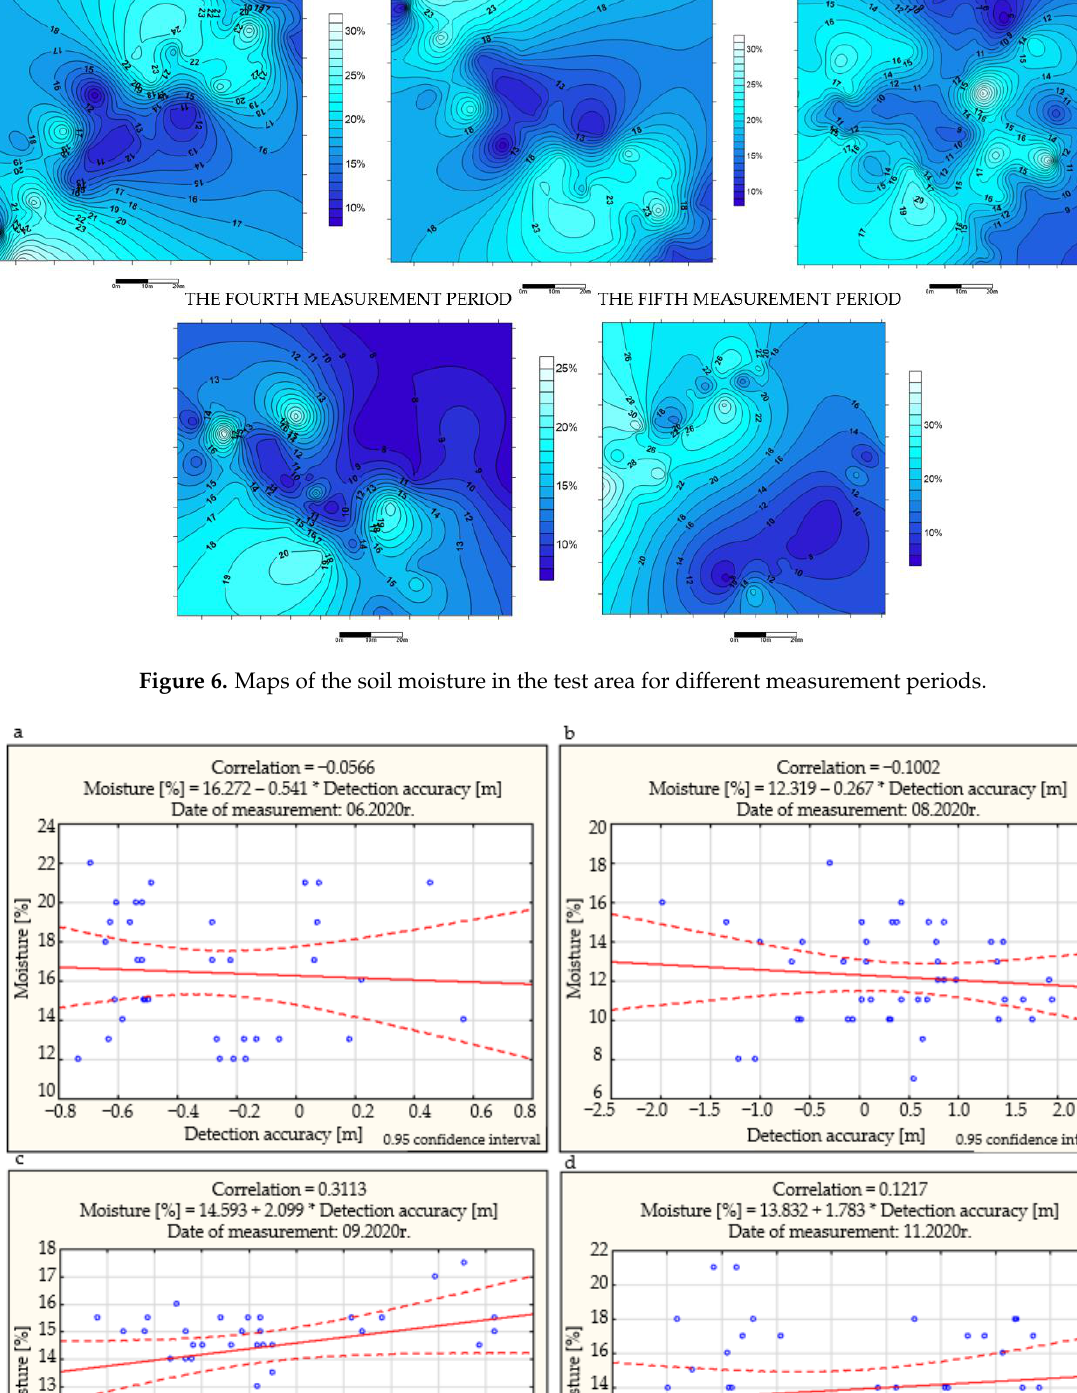
Figure 7. Results of the determination of the Bravais-Pearson coefficient in 5 measurement periods: ( a ) 06.2020, ( b ) 08.2020, ( c ) 09.2020, ( d ) 11.2020, ( e ) 01.2021. The maps of isohumes reveal that in summer and autumn, soil moisture values in the tested area were slightly lower than in winter and spring. Figure 7c shows that the third test period was the only one where the prerequisite for considering a slight correlation between GPR detection accuracy and soil moisture occurred. In this case, the correlation coefficient was 0.3. This leads to the conclusion that GPR detection conducted in various seasons of the year is equally accurate, and the influence of soil moisture on its accuracy may be omitted.